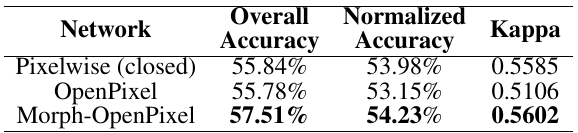
Table 2. Normalized Accuracy and Kappa Index obtained by the OpenPixel method and baselines.